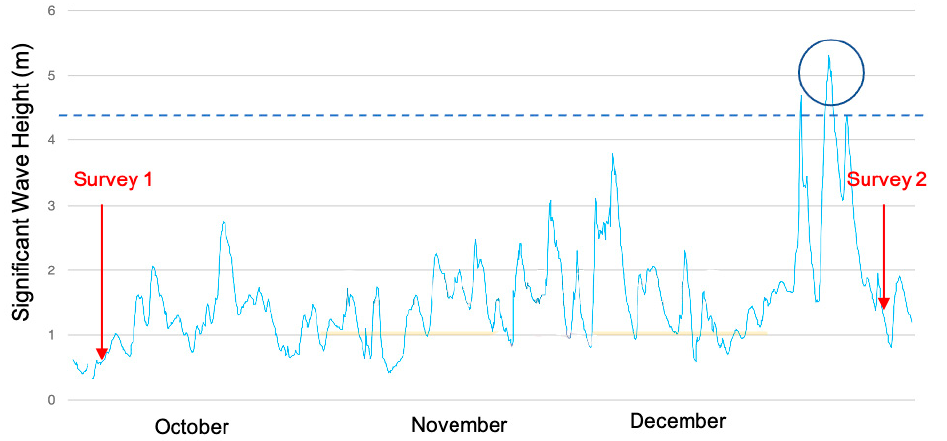
Figure 9. Significant wave height (m) conditions between the UAV surveys (red arrows), the wave storm threshold adopted for this study (blue dashed line), and the December storm conditions (blue circle). Wave data were obtained from the Port Authorities of Spain (http://www.puertos.es accessed on 1 October